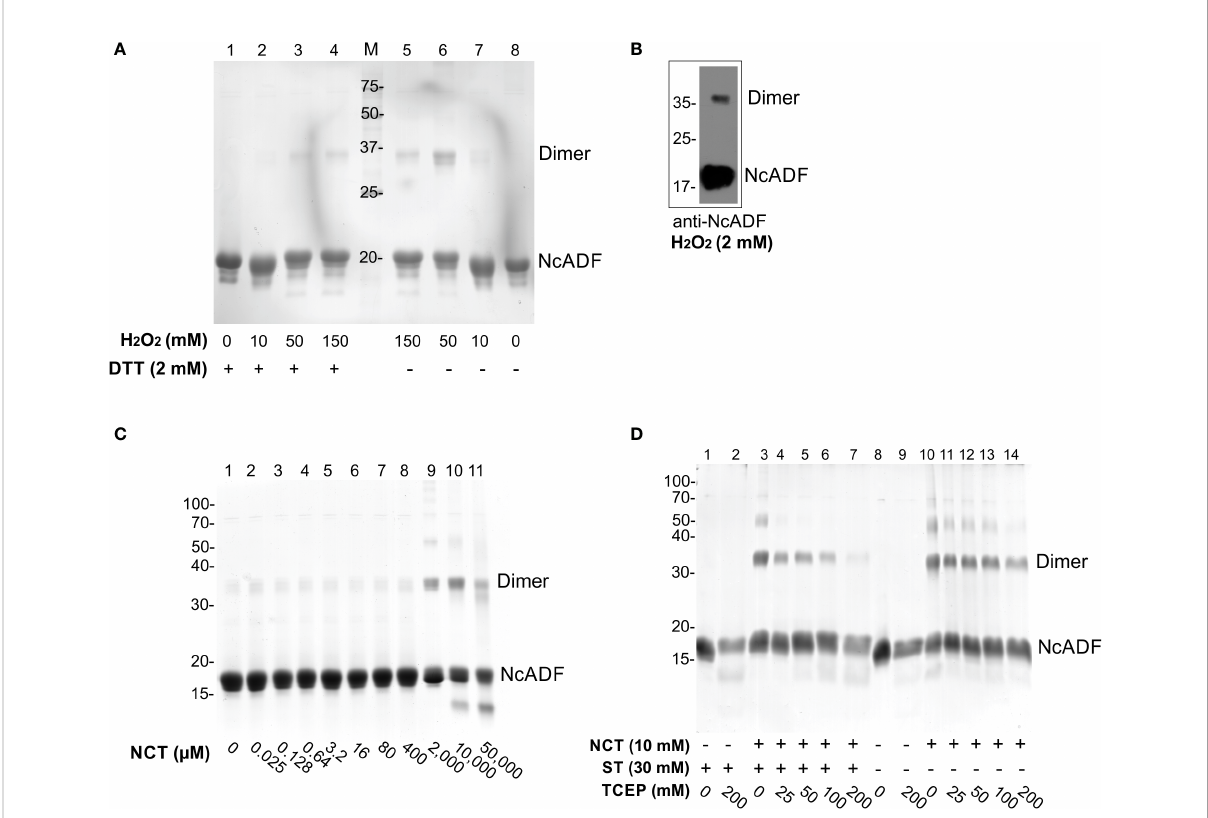
FIGURE 1 Dimerization of oxidized recombinant NcADF. NcADF produced and stored without reductant was incubated with oxidants. (A) NcADF was incubated with 0-150 mM of H 2 O 2 for 30 min. (B) NcADF was incubated with 2 mM H 2 O 2 and NcADF was detected by western blotting using NcADF antiserum (1:15,000) and anti-mouse secondary antibody conjugated to HRP (1:10,000). (C) NcADF was incubated with 0-50 mM NCT for 30 min. (D) NcADF was incubated with 10 mM NCT, followed by NCT inactivation with sodium thiosulfate (ST) and reduction with TCEP. 15% SDS-PAGE stained with Coomassie G-250 (A, C, D)